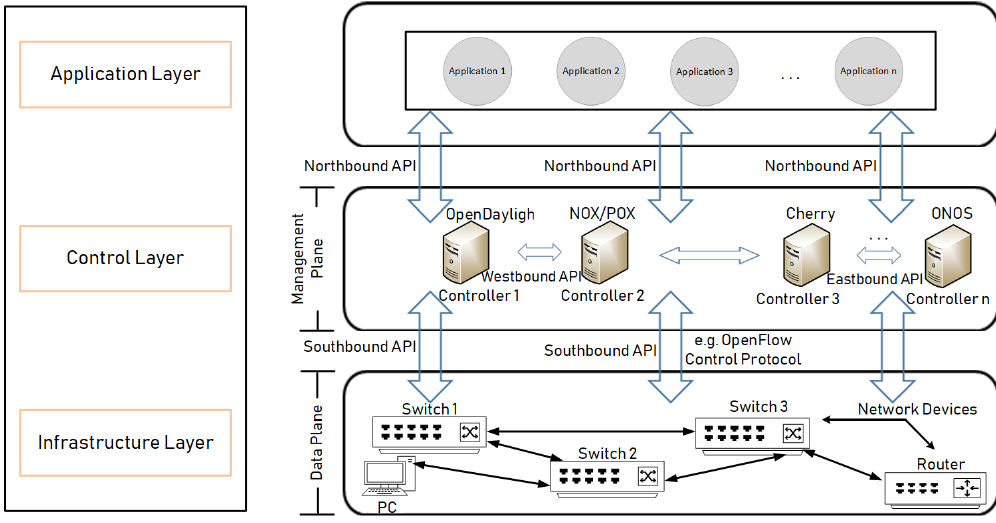
Figure 6. Diagramatic illustration of an SDN